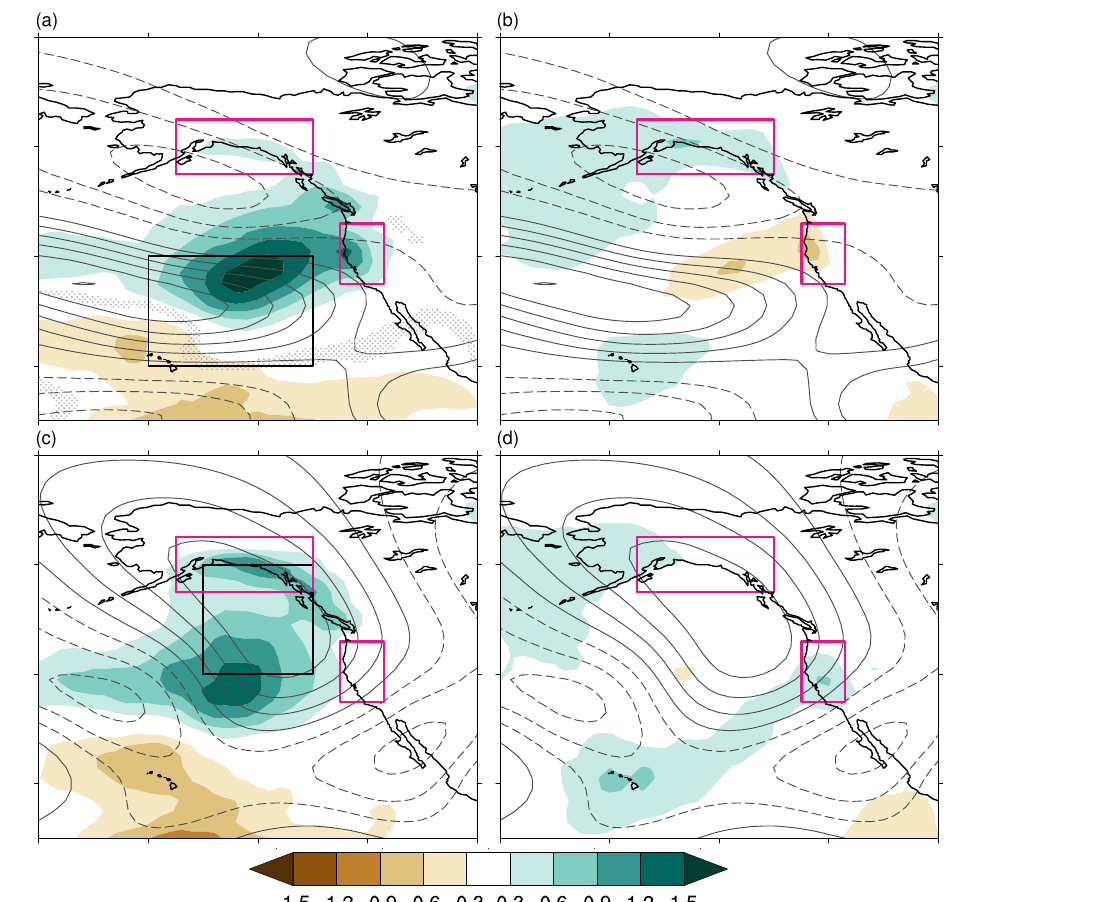
Figure 17. Multi-model mean precipitation signals associated with wind changes over western North America in the 2.0 ◦ C experiment during winter (DJF). (a, b) Composites of precipitation (units: mmd − 1 ) based on westerly u 250 changes in the North Pacific jet exit (area indicated by the black box), over members with the (a) 5% strongest and (b) 5% weakest westerly responses. Contours show the u 250 climatology (contour interval 0.5ms − 1 ; zero contour omitted) for the PD experiment. (c, d) Composites of precipitation (units: mmd − 1 ) based on southerly v 250 ∗ changes off the coast (area indicated by the black box), over members with the (c) 5% strongest and (d) 5% weakest southerly responses. Contours show the v 250 ∗ climatology (contour interval 0.4ms − 1 ; zero contour omitted) for the PD experiment, where v 250 ∗ is the departure from the zonal mean of the meridional wind at